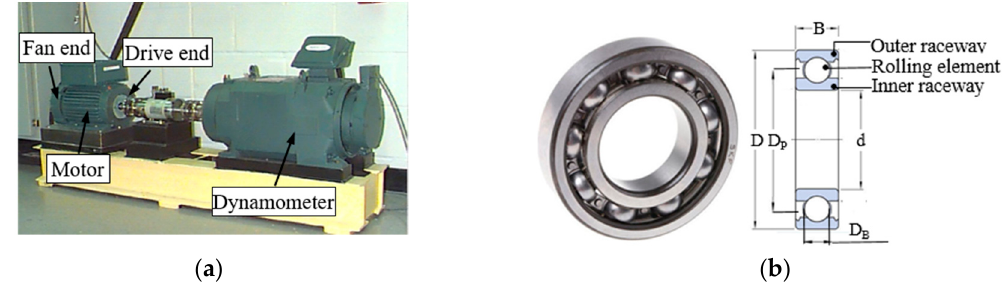
Figure 4. The test stand and structure of tested rolling element bearing of the Case Western Reserve University (CWRU) datasets: ( a ) The test stand of CWRU datasets; ( b ) Structure of the tested bearing in drive end.